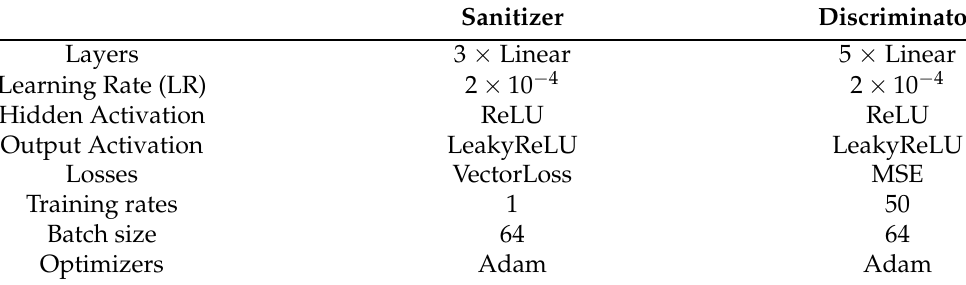
Table 3. Hyper parameters of neural networks for Adult/German